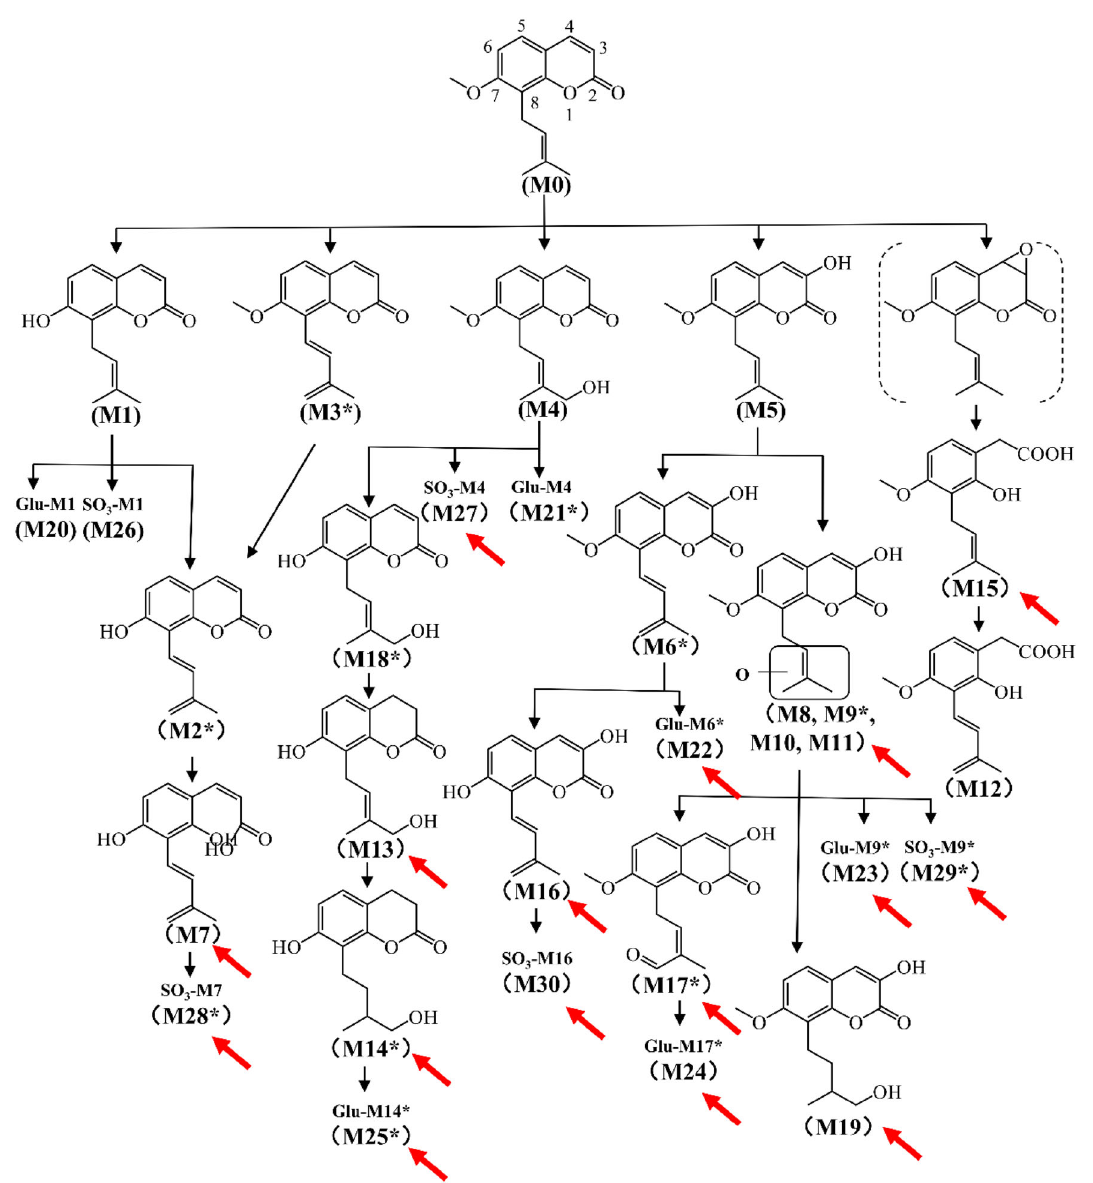
Fig. 3 Metabolic map of osthole by using metabolomics. Metabolites marked with asterisk (*) represent isomers were observed. Novel metabolites discovered by UPLC-ESI-QTOFMS-based metabolomics were shown by red arrows. Reproduced with permission from